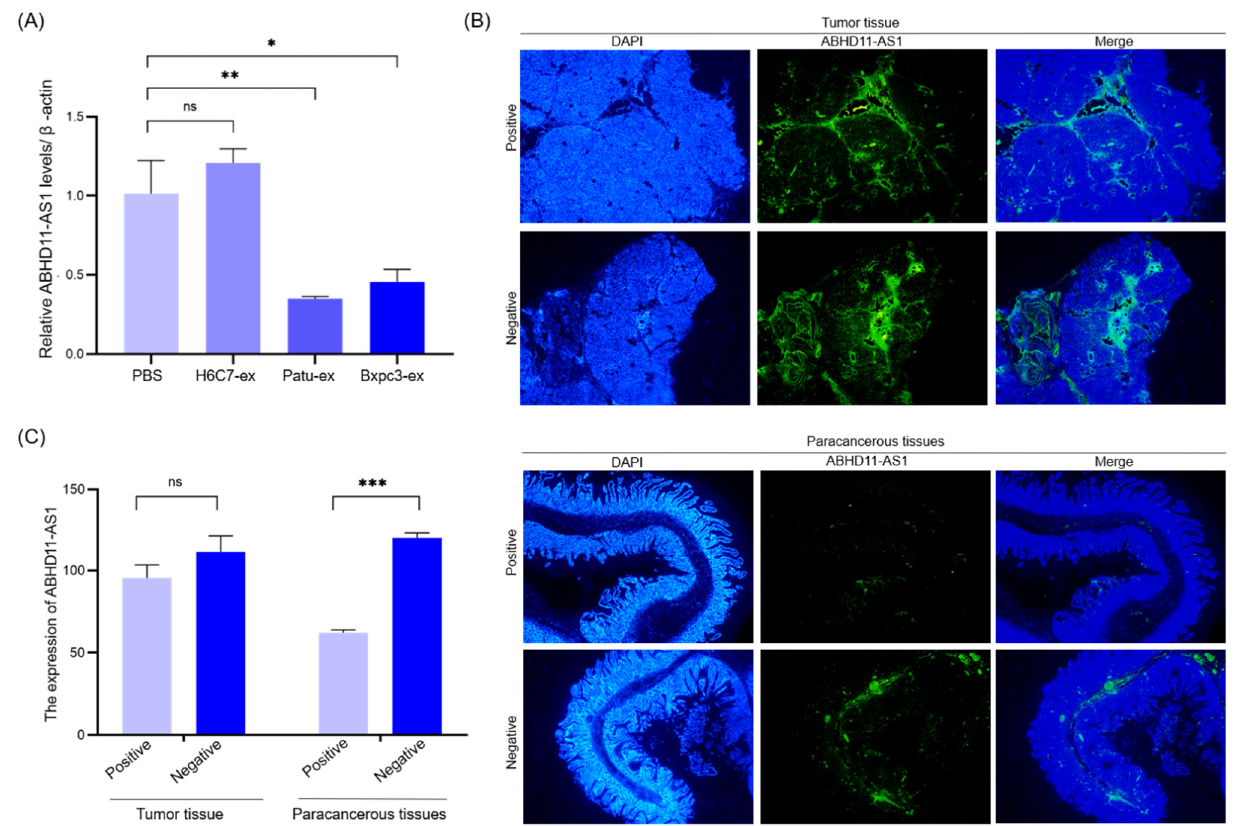
Figure 4. Exosomes from pancreatic cancer cells suppress the expression of ABHD11-AS1 in HLECs. ( A ) The relative expression of ABHD11-AS1 in HLECs after cultivating with exosomes (400 μ g/mL) was tested with real-time PCR ( n = 3). ( B ) The expression of ABHD11-AS1 was detected in tumor tissues and paracancerous tissues by the FISH assay. ( C ) Statistical analysis of the FISH assay ( n = 3). * p < 0.05. ** p < 0.01, *** p < 0.001.